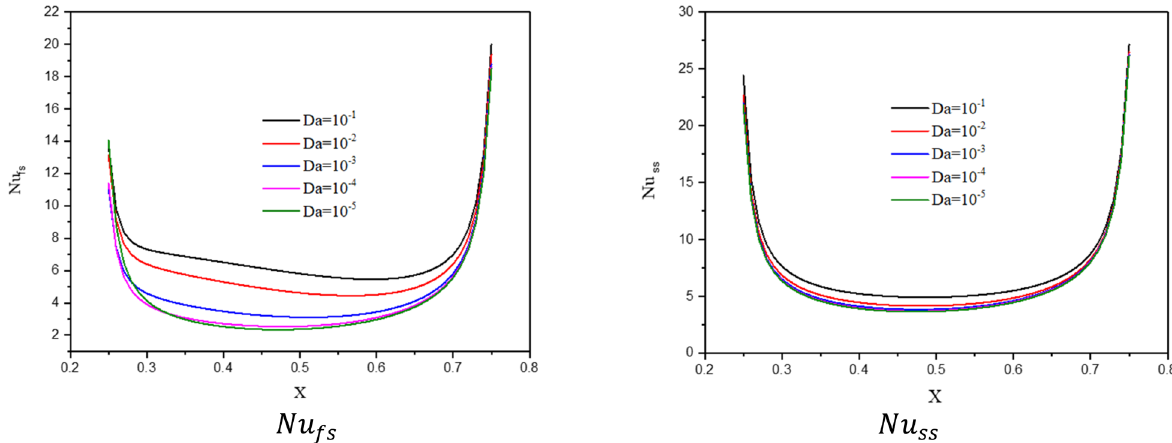
Figure 20. Profiles of Nu fs and Nu ss below the changes on Darcy parameter for a hybrid nanofluid at φ Cu = φ TiO 2 = φ/ 2, φ = 0.05, B = 0.5, Q = 1, R d = 0.5, k r = 1, ε = 0.5, k fs = 1, D = 0.5, H ∗ = 10, Ha = 10.